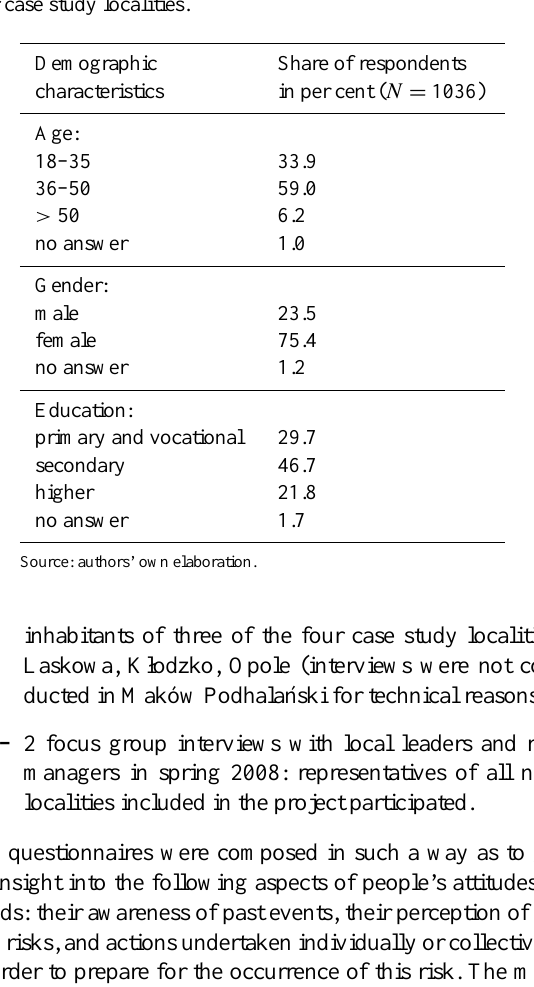
Table 2. Demographic characteristics of the respondents from the four case study